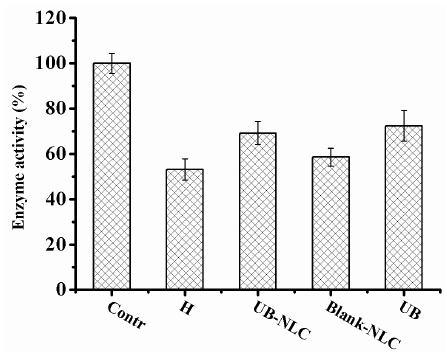
Figure 9. SOD activity of HaCaT cells during culture period with or without UB-NLC.